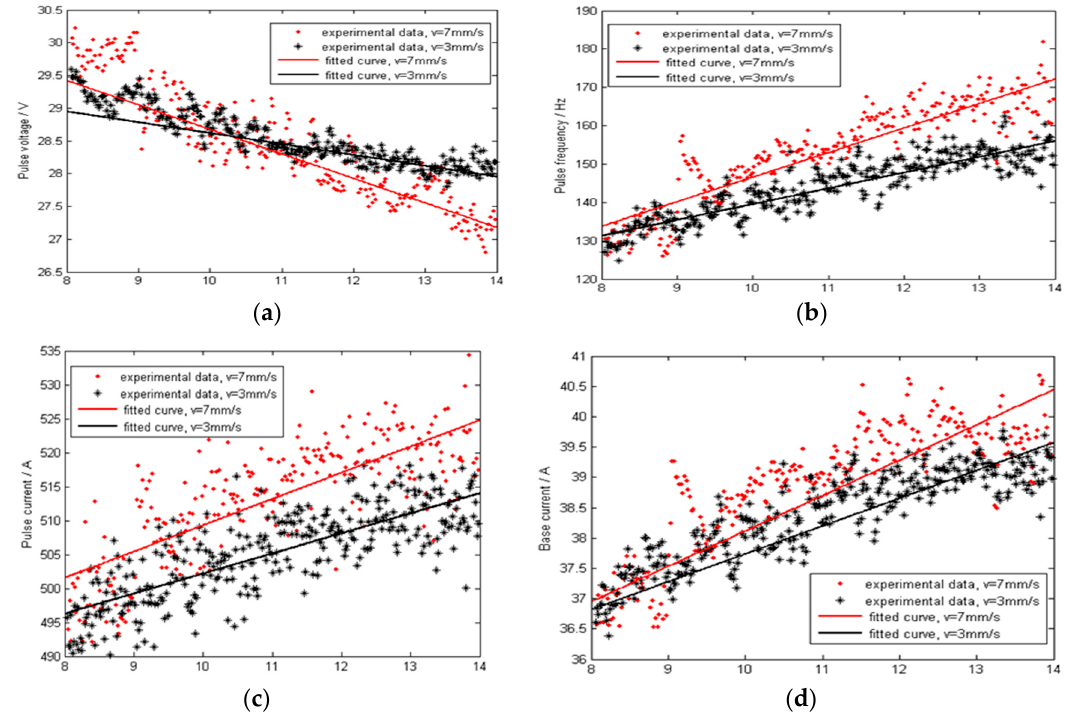
Figure 15. Effects of welding speed on the arc signal when uphill welding: ( a ) Pulse voltage; ( b ) Pulse frequency; ( c ) Pulse current; ( d ) Base current.